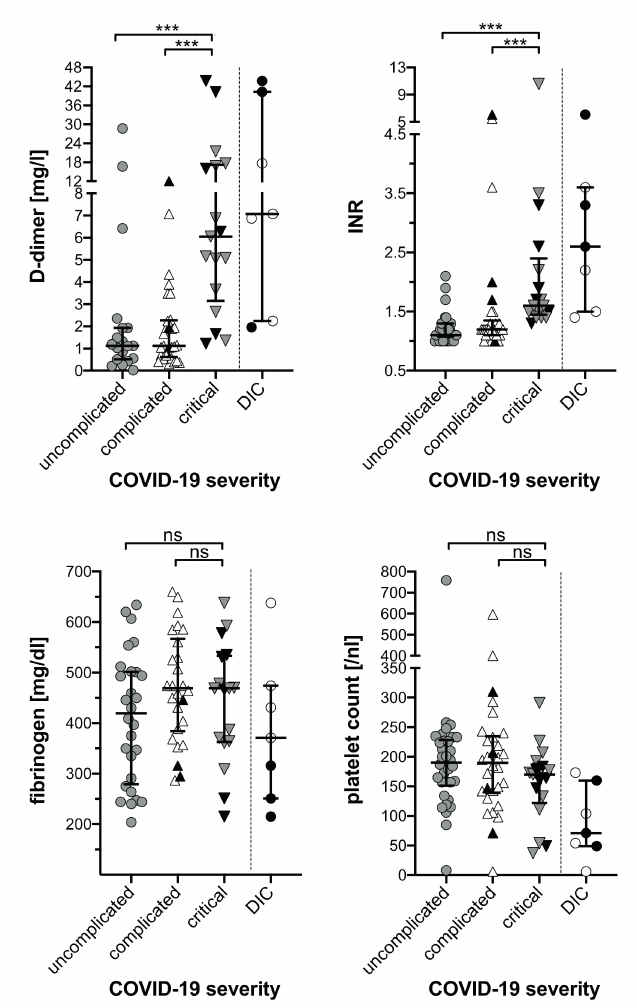
Figure 1. Haemostasis parameters of COVID-19 patients. The highest values for D-dimer and INR as well as the lowest values for fibrinogen and platelet count are plotted against the severity of COVID-19 disease and the occurrence of DIC as indicated. Black symbols represent laboratory values of deceased COVID-19 patients. Median and interquartile range are provided. Comparisons between subgroups were based on Mann–Whitney U Test (ns, not significant; *** p < 0.001). COVID-19, coronavirus disease-19; DIC, disseminated intravascular coagulation; INR, international normalized